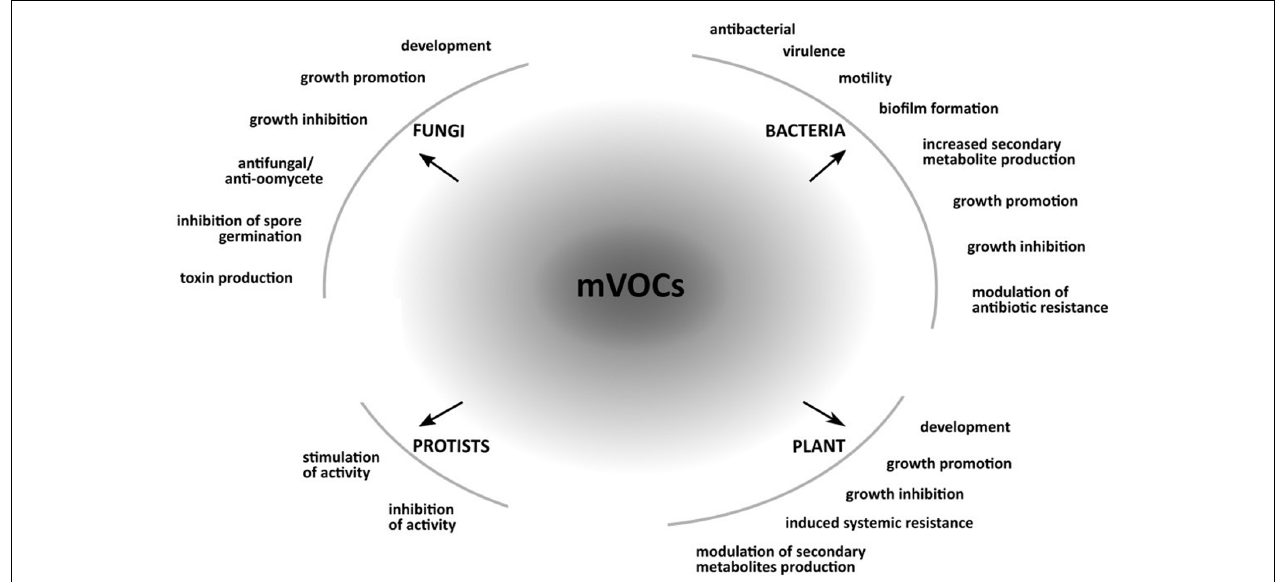
FIGURE 1 | Responses in bacteria, fungi, protists and plants caused by microbial volatile organic compounds (mVOCs). The figure shows examples of responses caused my mVOCs in bacteria, fungi, protists, and plants.